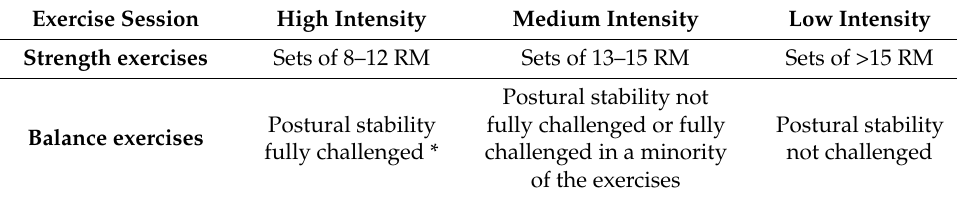
Table 2. Intensity scales of HIFE